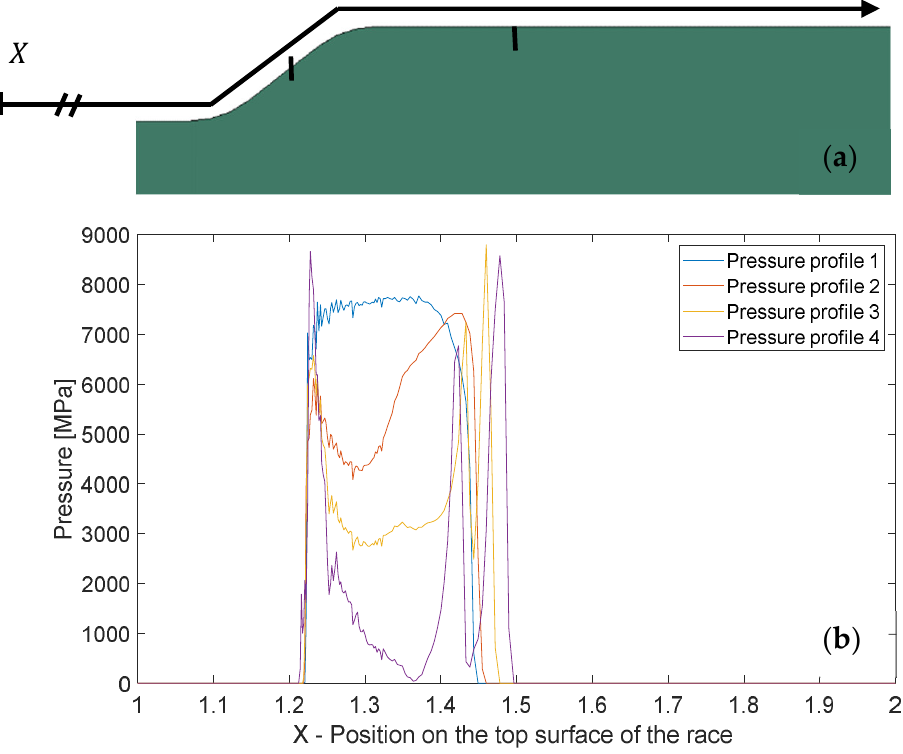
Figure 13. ( a ) Part of the spall edge from the model with axis X that represents the location on the race. ( b ) Four different pressure distributions produced from the simulation as a result of four different damage conditions (“Pressure profile 1” applies to the initial state; Profiles 2–4 apply to the damaged spall edge).